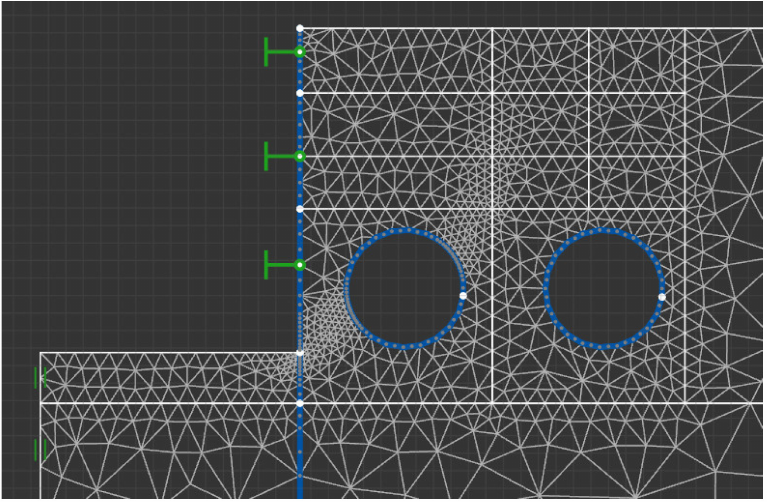
Figure 6. Final adaptive meshes of adjacent construction after five